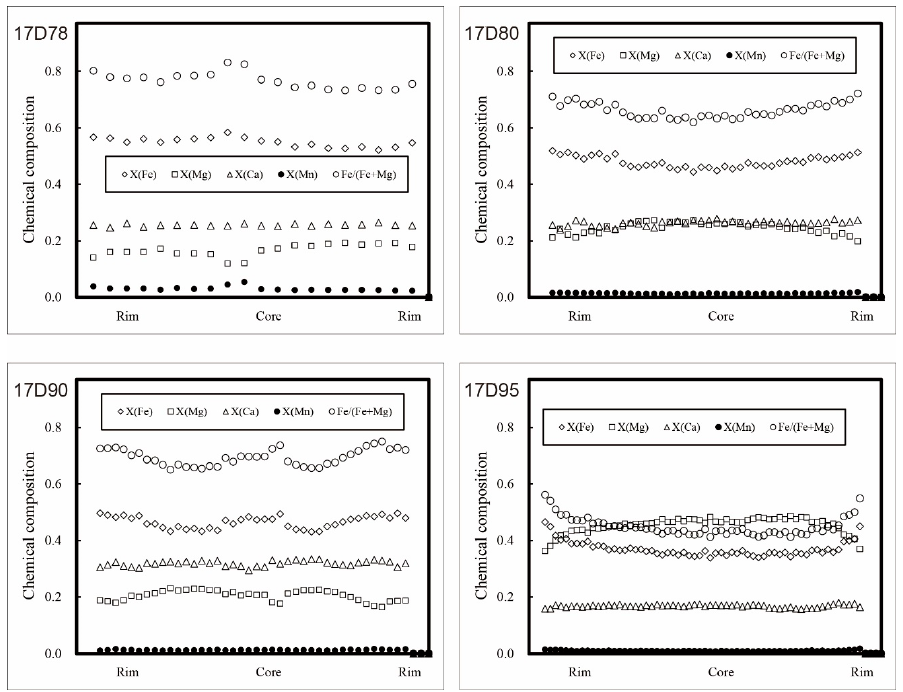
Figure 4. Chemical compositional profiles of the garnet porphyroblast in samples 17D78, 17D80, 17D90, and 17D95.